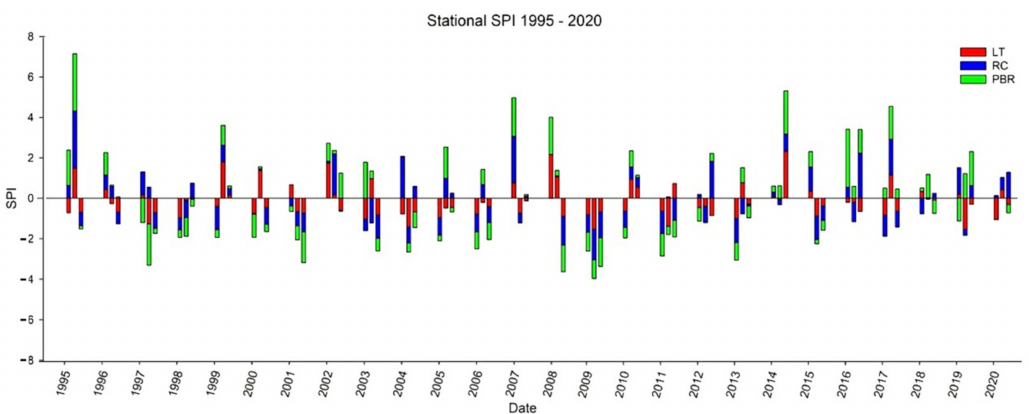
Figure 4. Standardized Precipitation Index (SPI) for the period of 1995 to 2020. SPI was calculated based on the annual precipitation data for 53 stations along the coasts of Campeche. Total annual precipitation differed significantly between sites (F = 11.25, p < 0.0001), years (F = 8.86, p < 0.003) and seasons (F = 290.21, p < 0.0001) and a significant year–season interaction was detected (F = 32.31, p < 0.0001). Precipitation significantly differed between sites (LT vs. RBP and LT vs. CR) and between seasons in 2009 and 2010 ( p < 0.05; Figure 5) (Table 2).